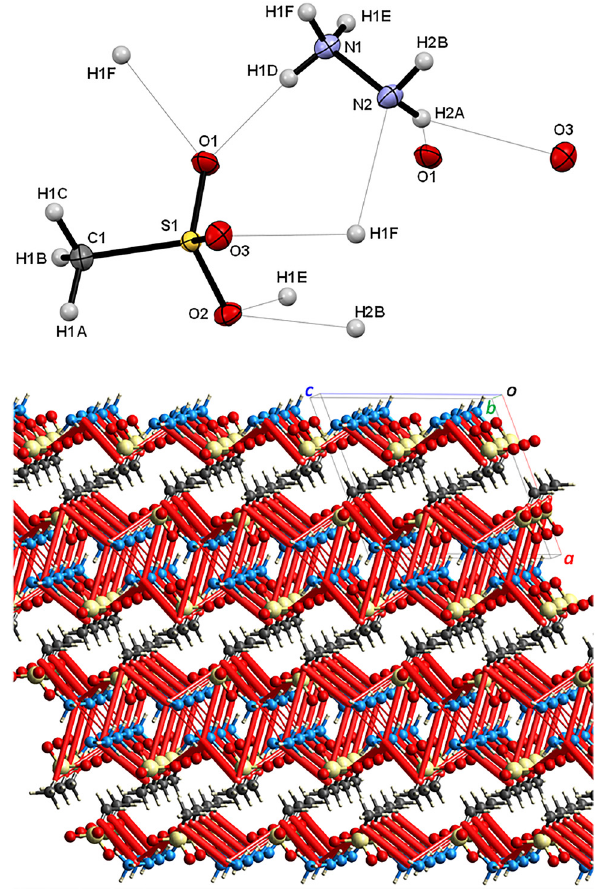
Table  : Data collection and